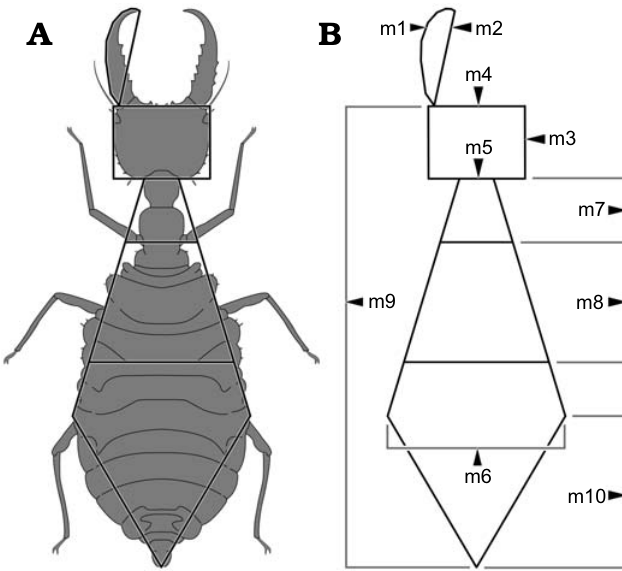
Fig. 1. Dimensions measured on the specimens. A . Example of an actual specimen (simplified from Monserrat 2008) to illustrate which dimensions were measured, resulting in a “net”. B . The naked “net”. Abbreviations: m1, mandible length including the curved shape; m2, mandible length in straight line; m3, head length; m4, head width; m5, “neck” width (located behind the end of the head); m6, widest point of the abdomen; m7, “neck” length (distance between the end of head and the fore legs); m8, distance between the fore pair of legs and the hind pair of legs; m9, total body length (head without mandible + thorax + abdomen); m10, distance be- tween widest point of the abdomen and hind part of the